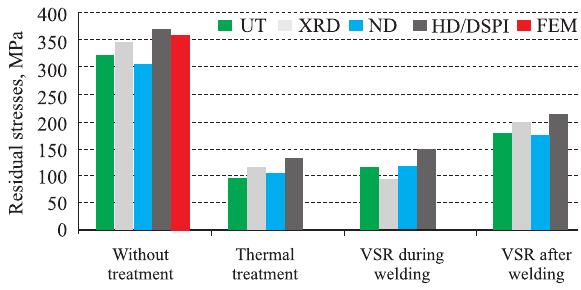
Fig. 5. Peak of longitudinal residual stresses in welded specimens, using different measurement